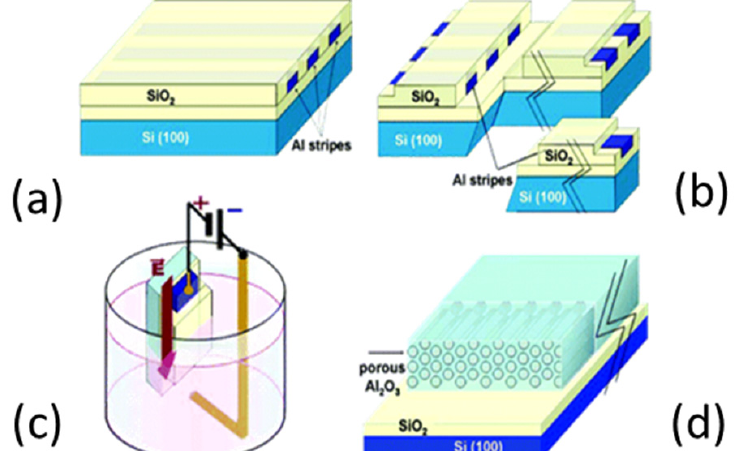
Figure 7. Sample processing and experimental setup for the fabrication of lateral-PAA templates. ( a ) A thin film of aluminium is first deposited on an insulating substrate (e.g., an oxidized Si wafer) and etched into parallel stripes. The Al stripes are subsequently capped with an insulating layer (SiO 2 , SiN x , resist.). ( b ) The capping insulating layer is also patterned (and etched) in large stripes, leaving the Al locally exposed. Al is then locally etched using the capping layer as a mask. The mask is also removed at the periphery to provide an electrical contact area to the Al thin film. Finally, the Si substrate is cleaved into several individual stripes. ( c ) Individual Al stripes (connected at the periphery) are partially immersed into the electrochemical bath for anodic oxidation. As a result of the engineered structure of Figure ( b ), the anodic oxidation current is forced to flow parallel to the surface of the substrate. Hence the porous structure is also forced to develop parallel to the surface of the substrate as schematically shown in ( d ). The lateral-PAA templates sketch are reprinted with permission from Ref. [115]. Copyright 2005 American Chemical Society.